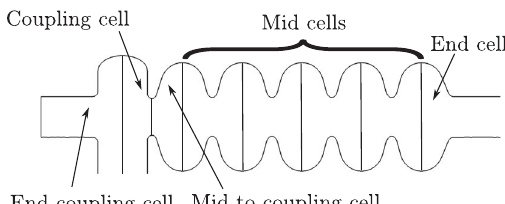
FIG. 5. Schematic of one axis of the